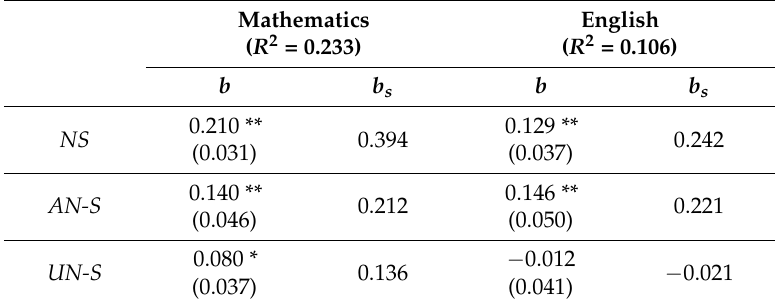
Table 8. Multivariate Regression analyses with the Mathematics and English Grades as Dependent Variables and the Three Factors of the Bifactor( S -1) Model as Independent Variables (Reference Facet = Number